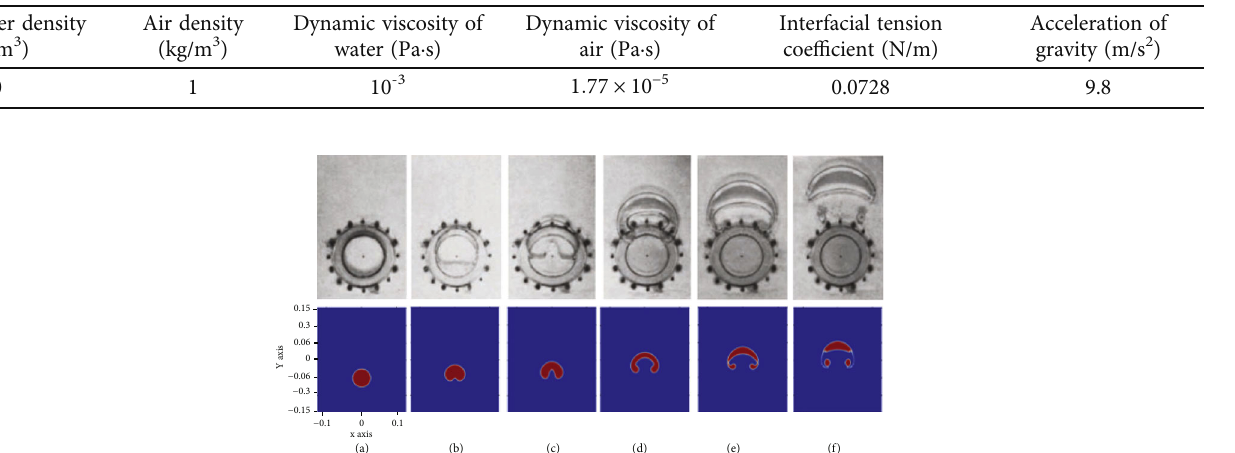
Table 3: Physical parameters in the simulation of bubble rising.